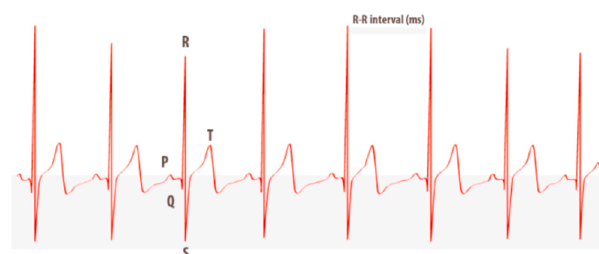
Figure 2. HRV means the variation in time between consecutive heartbeats.